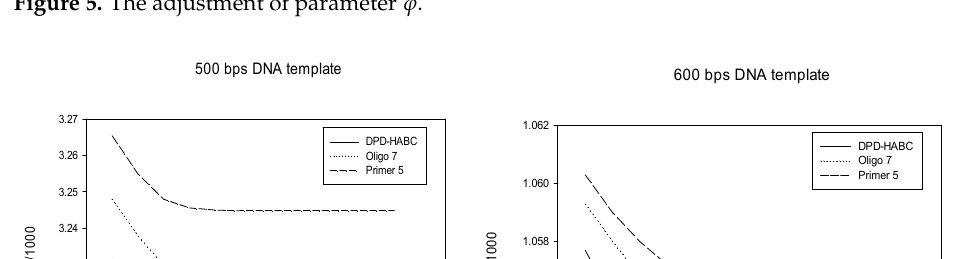
Figure 5. The adjustment of parameter ϕ .